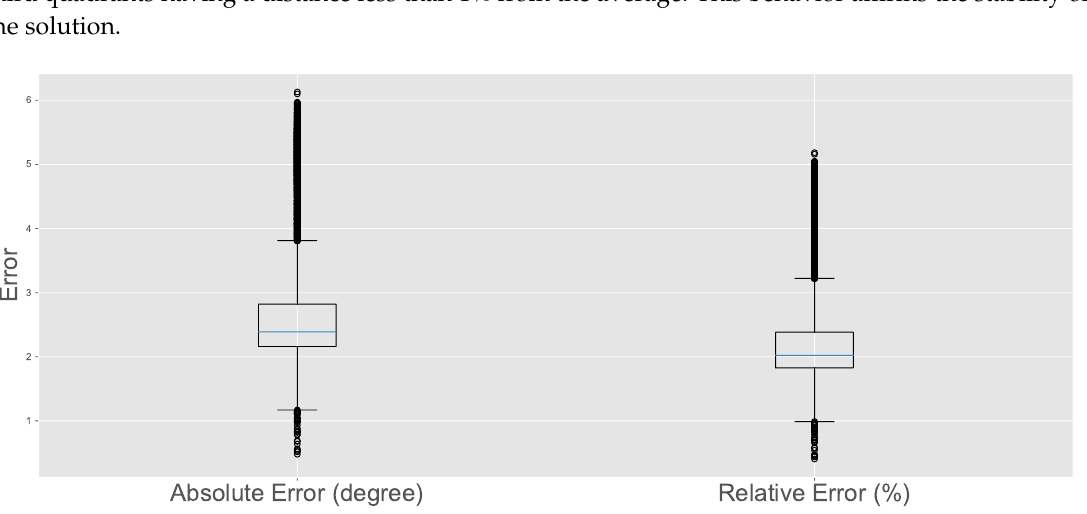
Figure 10. Analysis of absolute and normalized errors in the control of a degree of freedom.